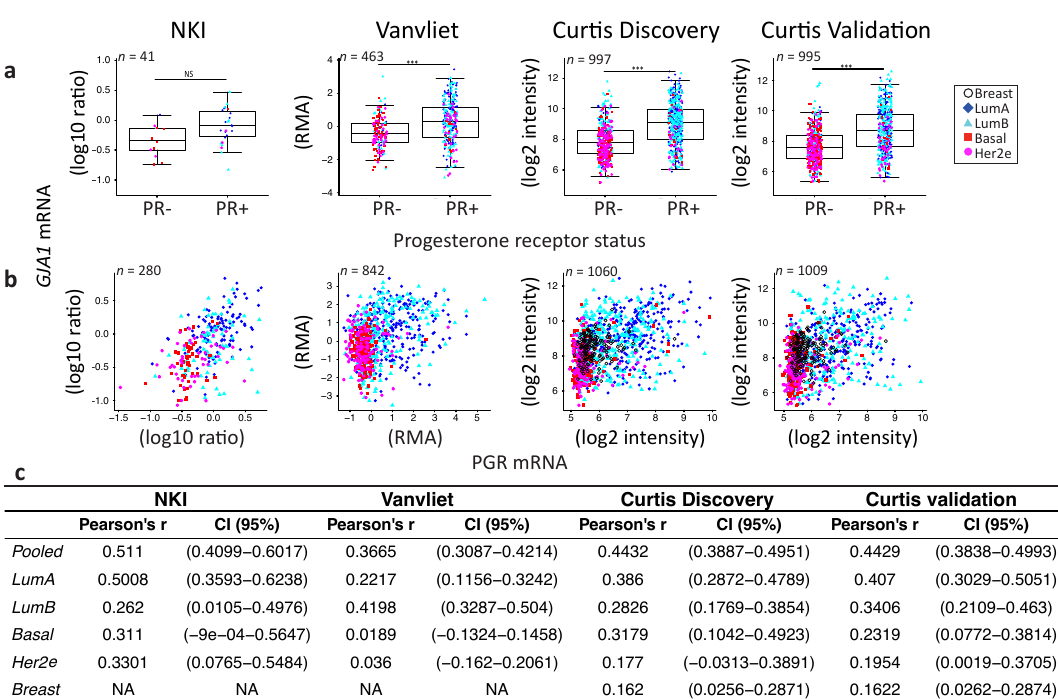
Supplementary Fig. S3. GJA1 mRNA level in breast cancer clinical samples increase with PGR expression in four dataset. Figure A3. GJA1 mRNA level in breast cancer clinical samples increases with PGR expression in four A, GJA1 mRNA level in breast tumors stratified by PR status determined as descrided in Material and Methods. p value: * < 0.05; ** < 0.01; *** < 0.001; B, Expression of GJA1 vs progesterone receptor (PGR) mRNA in each subtype and in normal breast tissue. C, Bootsrtapped correlations between PGR and GJA1 mRNA level either datasets. ( a ) GJA1 mRNA level in breast tumors stratified by PR status determined as described in in pooled BC tumors or in individual BC molecular subtypes; Data from Vanvliet, NKI, Curtis Discovery and Curtis Validation dataset. Material and Methods. In the legend, ”“Breast” indicates adjacent normal breast tissue. p value: * <0.05; ** <0.01; *** <0.001; NS Not statistically significant. ( b ) Expression of GJA1 vs. progesterone receptor (PGR) mRNA in each subtype and in normal breast tissue. ( c ) Bootstrapped correlations between PGR and GJA1 mRNA level either in pooled breast tumors or in individual breast cancer intrinsic subtypes. Data from Vanvliet, NKI, Curtis Discovery and Curtis Validation